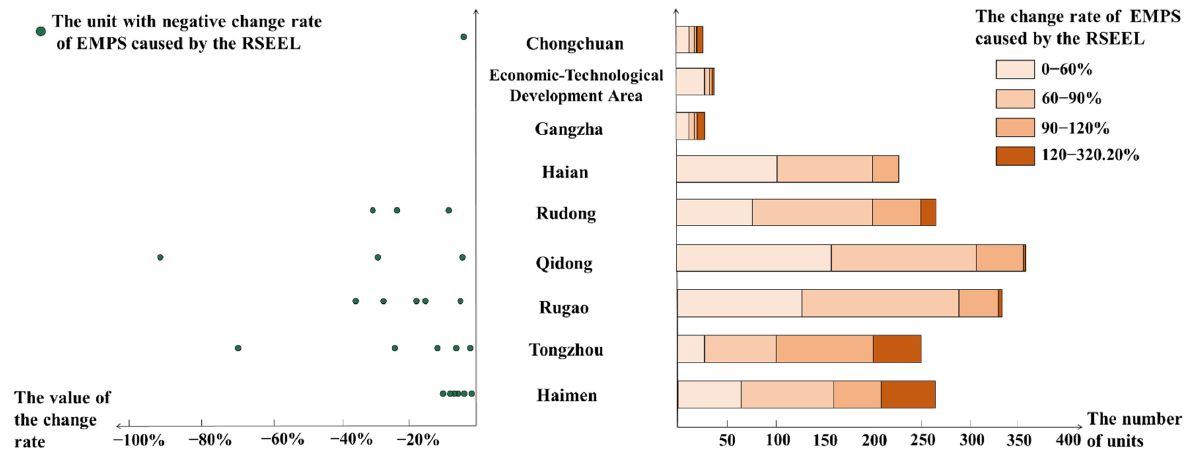
Figure 6. The change rate of EMPS caused by RSEEL in Nantong.